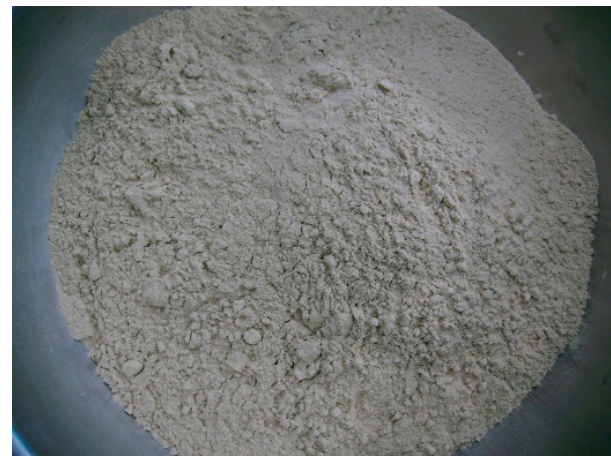
Figure 3. Flue gas desulfurization gypsum (FGD gypsum). Table 3. Properties of FGD gypsum and natural gypsum, adapted from [43,45–47]. Property Mineral